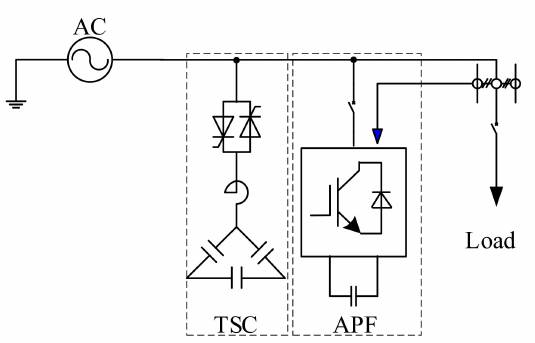
Figure 3. TSC and APF hybrid compensation.